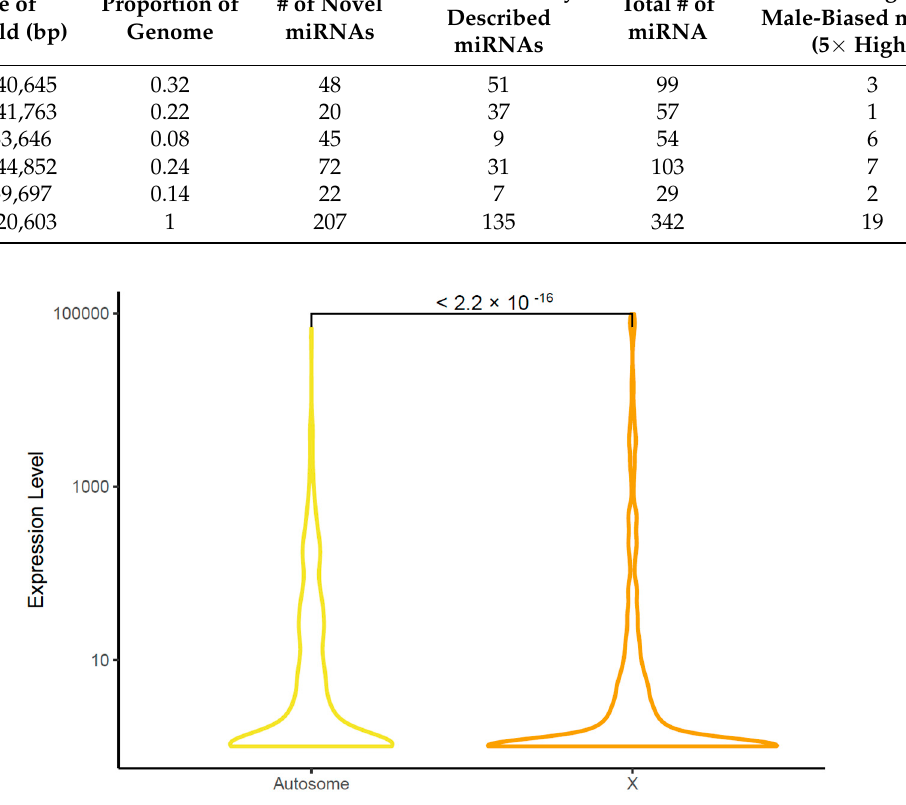
Figure 2. miRNA expression levels on autosomes versus the X chromosome. The expression level is